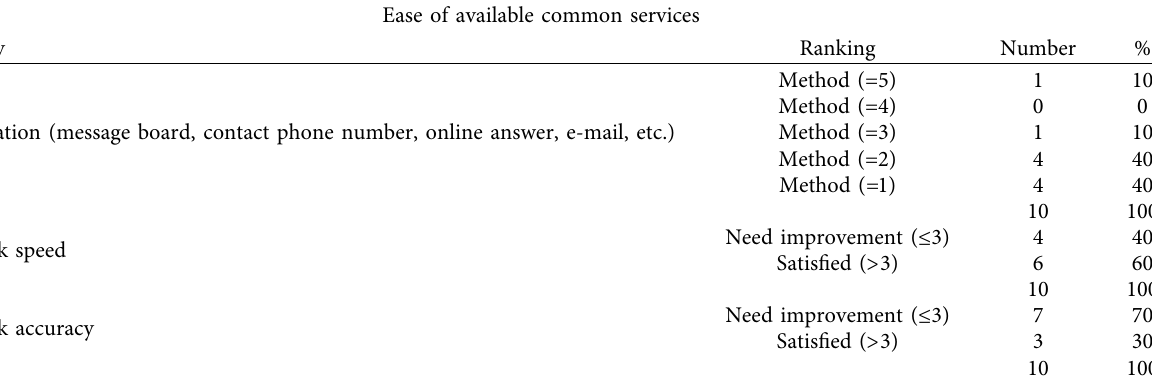
Table 13: Summary of the customer